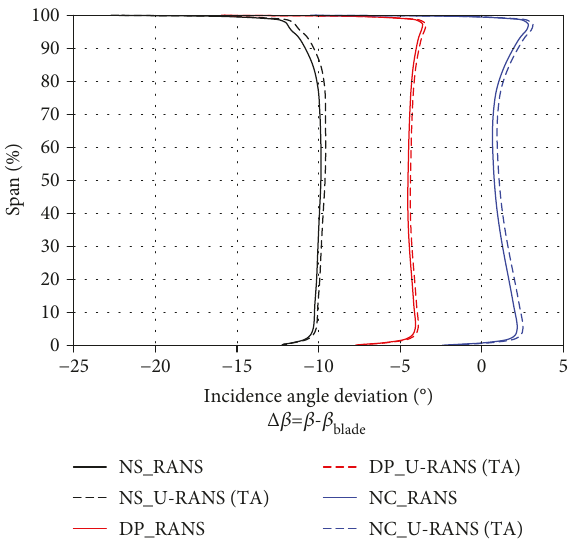
Figure 10: Incidence angle deviation distribution at the impeller inlet.